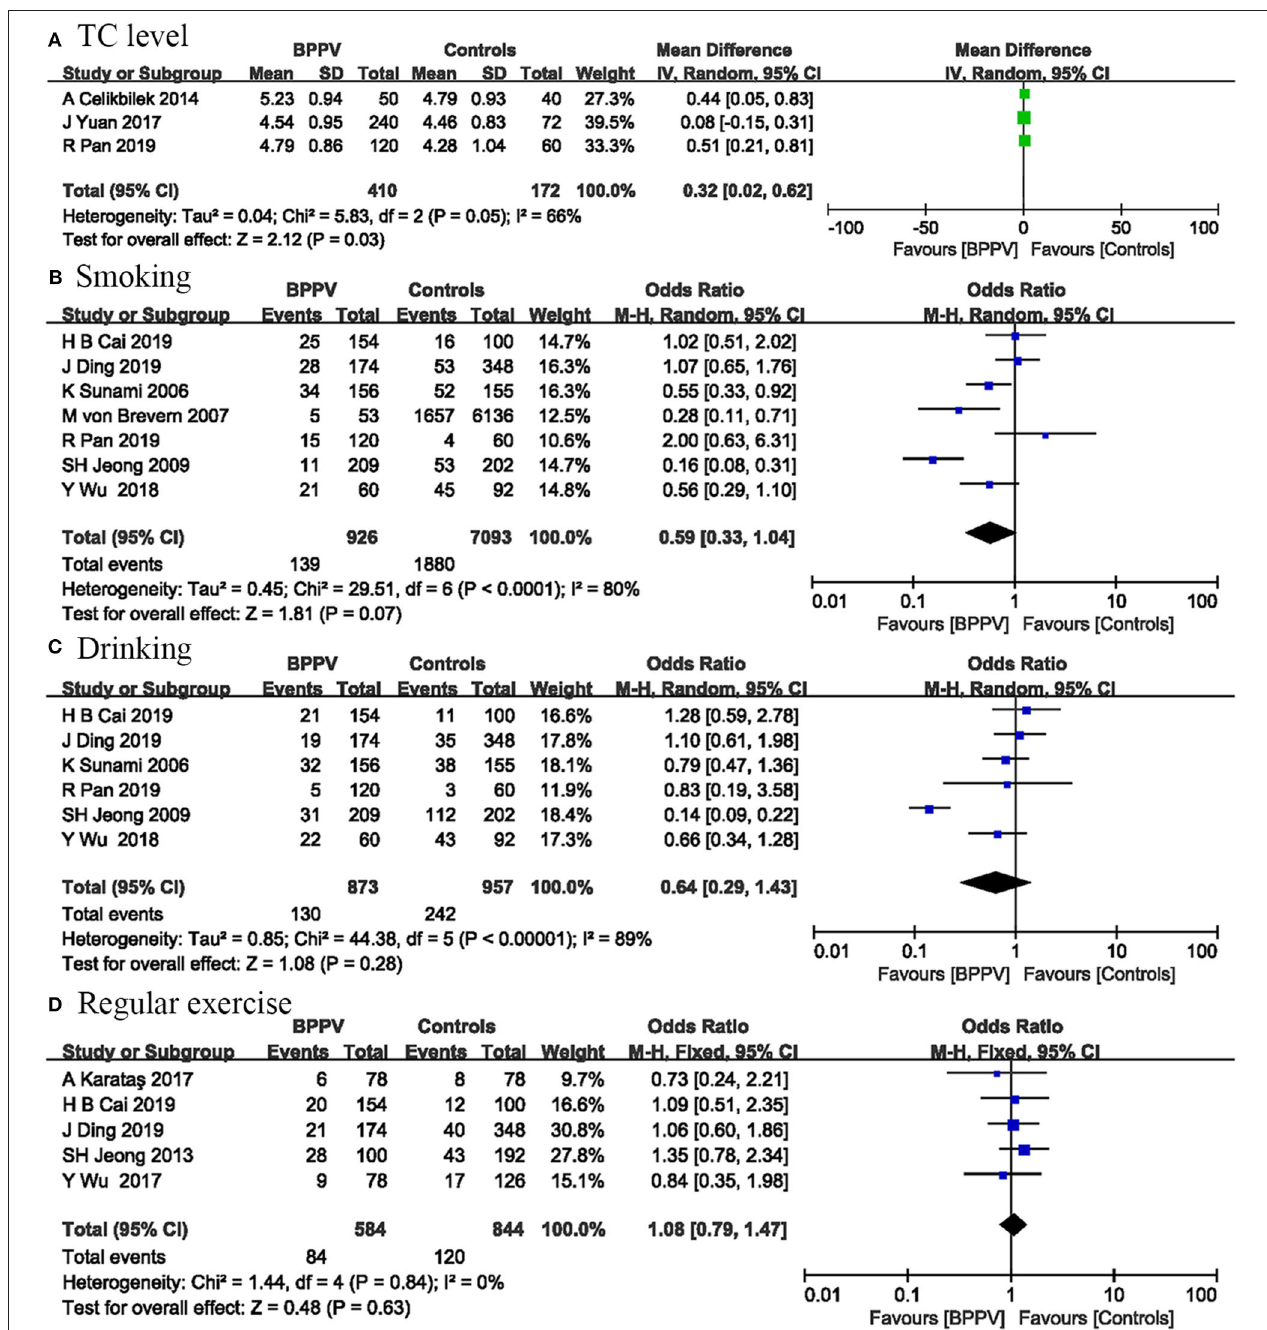
FIGURE 4 | Forest plot of TC level (A) and changeable lifestyles including smoking (B) , drinking (C) , and regular exercise (D) .